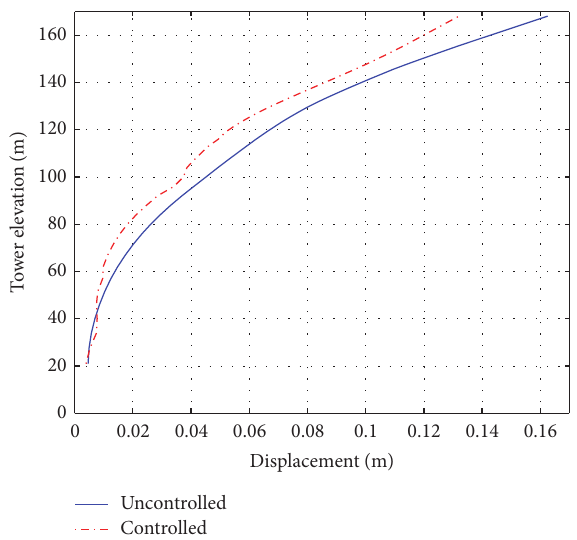
Figure 19: Displacement control result of total tower under earth-